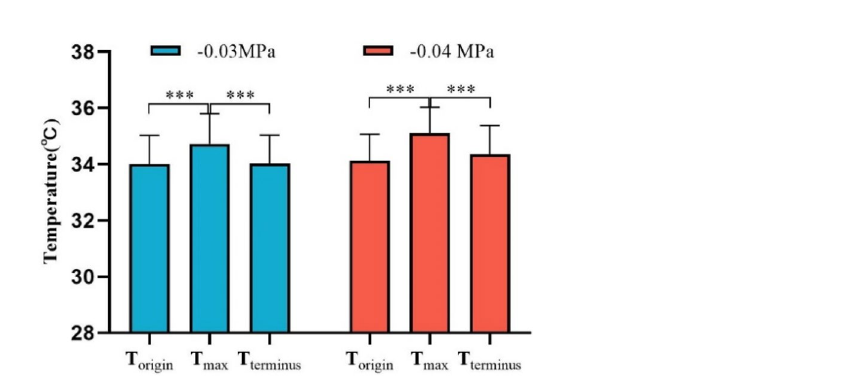
Figure 8. Comparison of the temperature values (original point, peak value and terminal point) at three representative moments after cupping (mean ± SD). *** P <